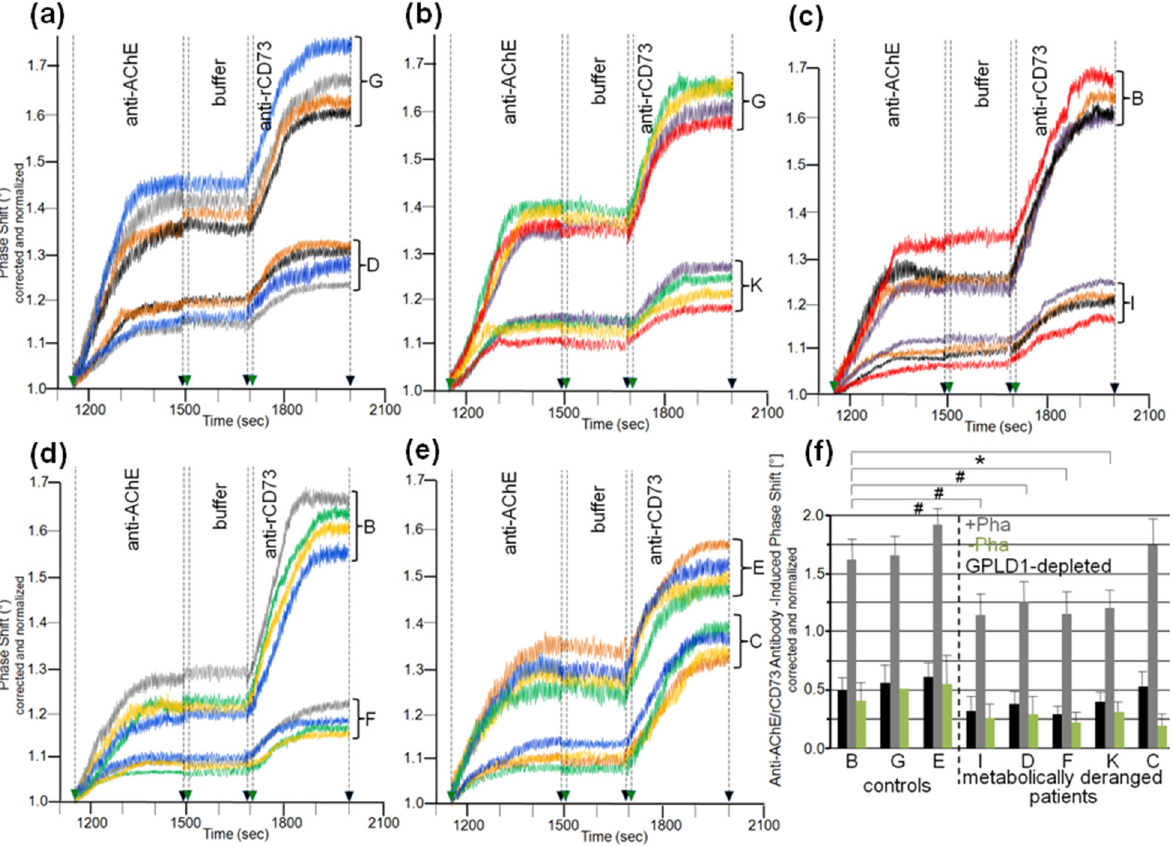
Figure 10. Differential inhibition of translocation of bAChE from micelle-like complexes to rat adipocytes by human serum. The experiment was performed as described for Figure 9 with initial incubation (180 min) of isolated rat adipocytes in the presence of micelle-like bAChE complexes (15 volume equivalents) and serum (10 volume equivalents) from controls or metabolically deranged patients ( a – e ) that had been left untreated in the presence of Pha ( a – f ) or its absence (only f ), or that had been depleted of GPLD1 in the presence of Pha (only f ). The limited number of probands prevented the clustering of age- and gender-matched cases and control groups. Therefore, samples “G” and “B” were used twice as controls for comparison with samples “D” and “K” ( a , b ) or “I” and “F” ( c , d ), respectively, and sample “E” was used once as control for sample “C” ( e ) during the same run. ( a – e ) Phase shift was measured in quadruplicate as indicated by the different colors of the curves with different incubations of the adipocytes following transfer of bAChE for its assaying as the amount subsequently released. Four independent measurements were performed per proband (distinct chips with different micelle-like bAChE complexes) indicated by the different colors of the curves. ( f ) The anti-AChE and rCD73 antibody-induced phase shift is given as means ± SD ( n = 4) for incubation of the adipocytes with micelle-like bAChE complexes and serum that had been left untreated (green bars) or treated with Pha (grey bars), or depleted of GPLD1 and treated with Pha (black bars). The comparison between the probands is shown for sera treated with Pha (grey bars) only (* p ≤ 0.01, # p ≤ 0.02).